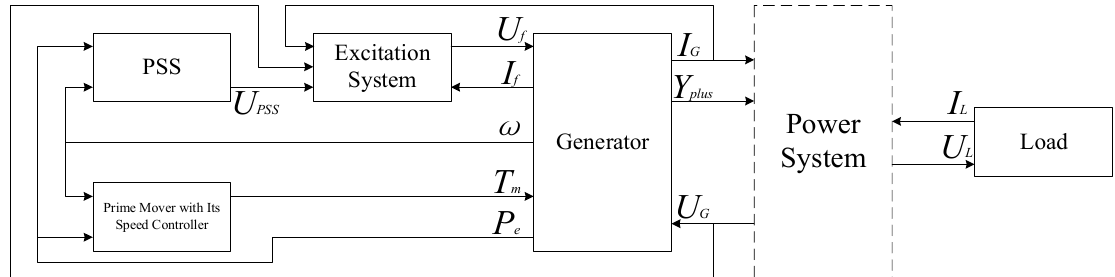
Figure 5. The input-output relationship among various devices and the power system. ω is the rotor angular velocity of the generator, P e is the electromagnetic power of the generator, T m is the mechanical torque provided by the prime mover, U PSS is the output of the power system stabilizers (PSS), U f is the exciting voltage, I f is the exciting current, I G and U G refer to the equivalent current source and the terminal voltage of the generator, respectively, Y plus is the additional admittance of the generator to the network, and I L and U L refer to the equivalent current source and the terminal voltage of the load, respectively.